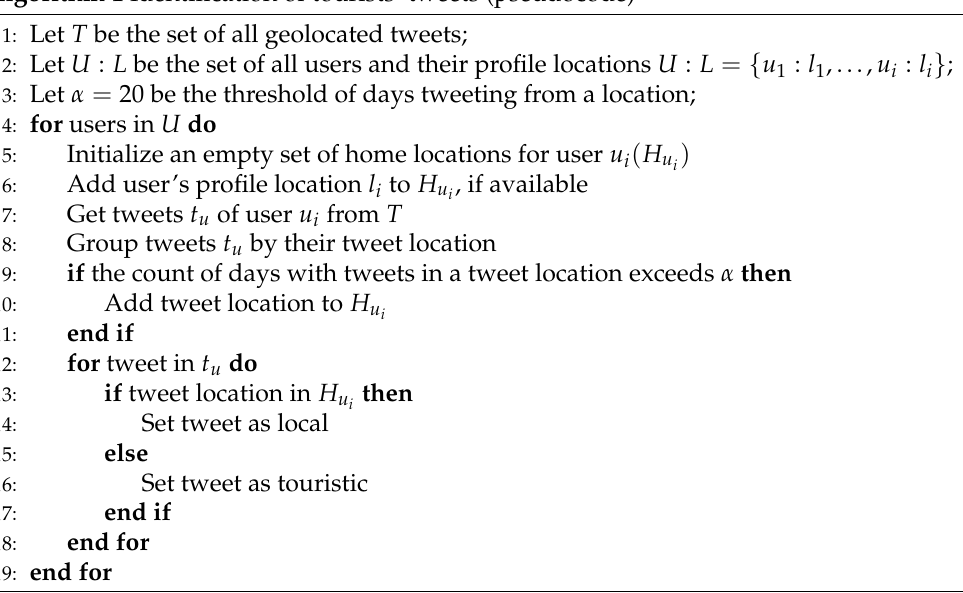
Algorithm 1 Identification of tourists’ tweets